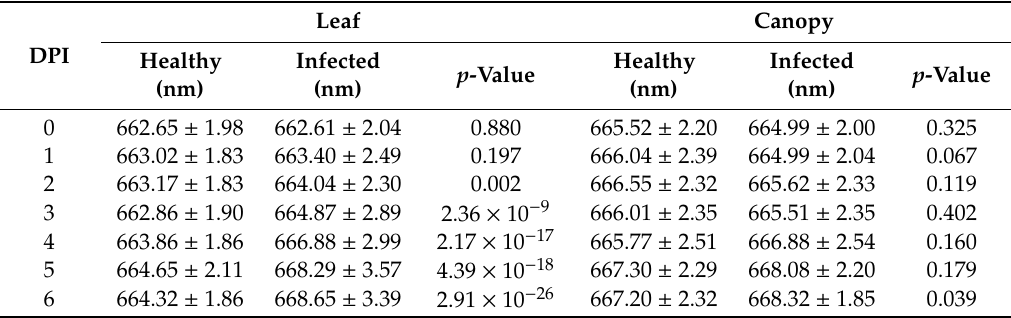
Table 1. Mean and standard variation of the red-well point (RWP) wavelength (in nm) and p -values for the t -test for mean comparison in the case of the leaf and canopy measurements as a function of the number of days post-inoculation (DPI).